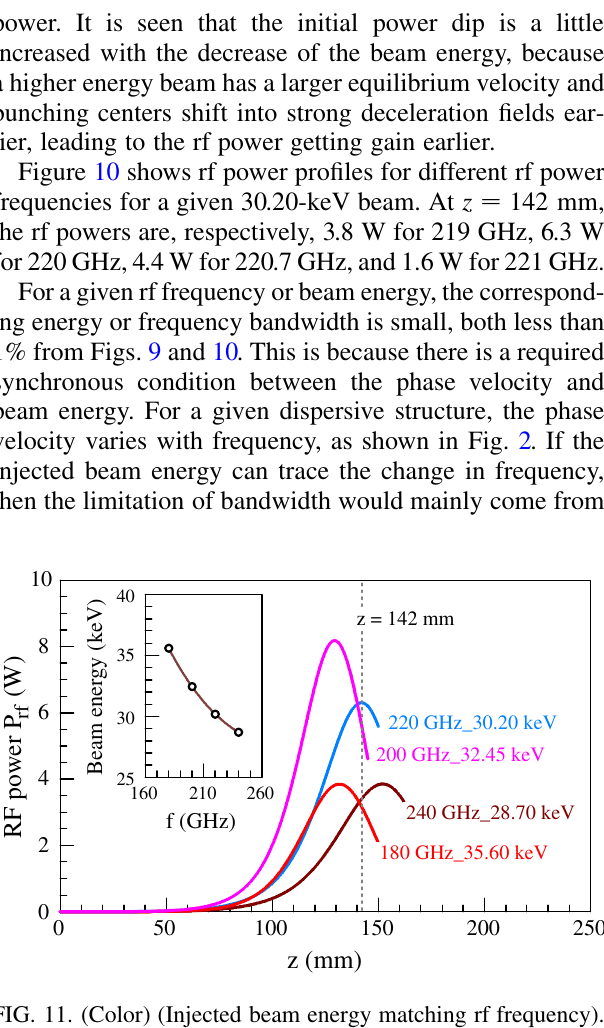
FIG. 12. (Color) The rf power profiles for different initial axial velocity spreads for a 30.2-keV beam. The rf power decreases with the increase of velocity spread.